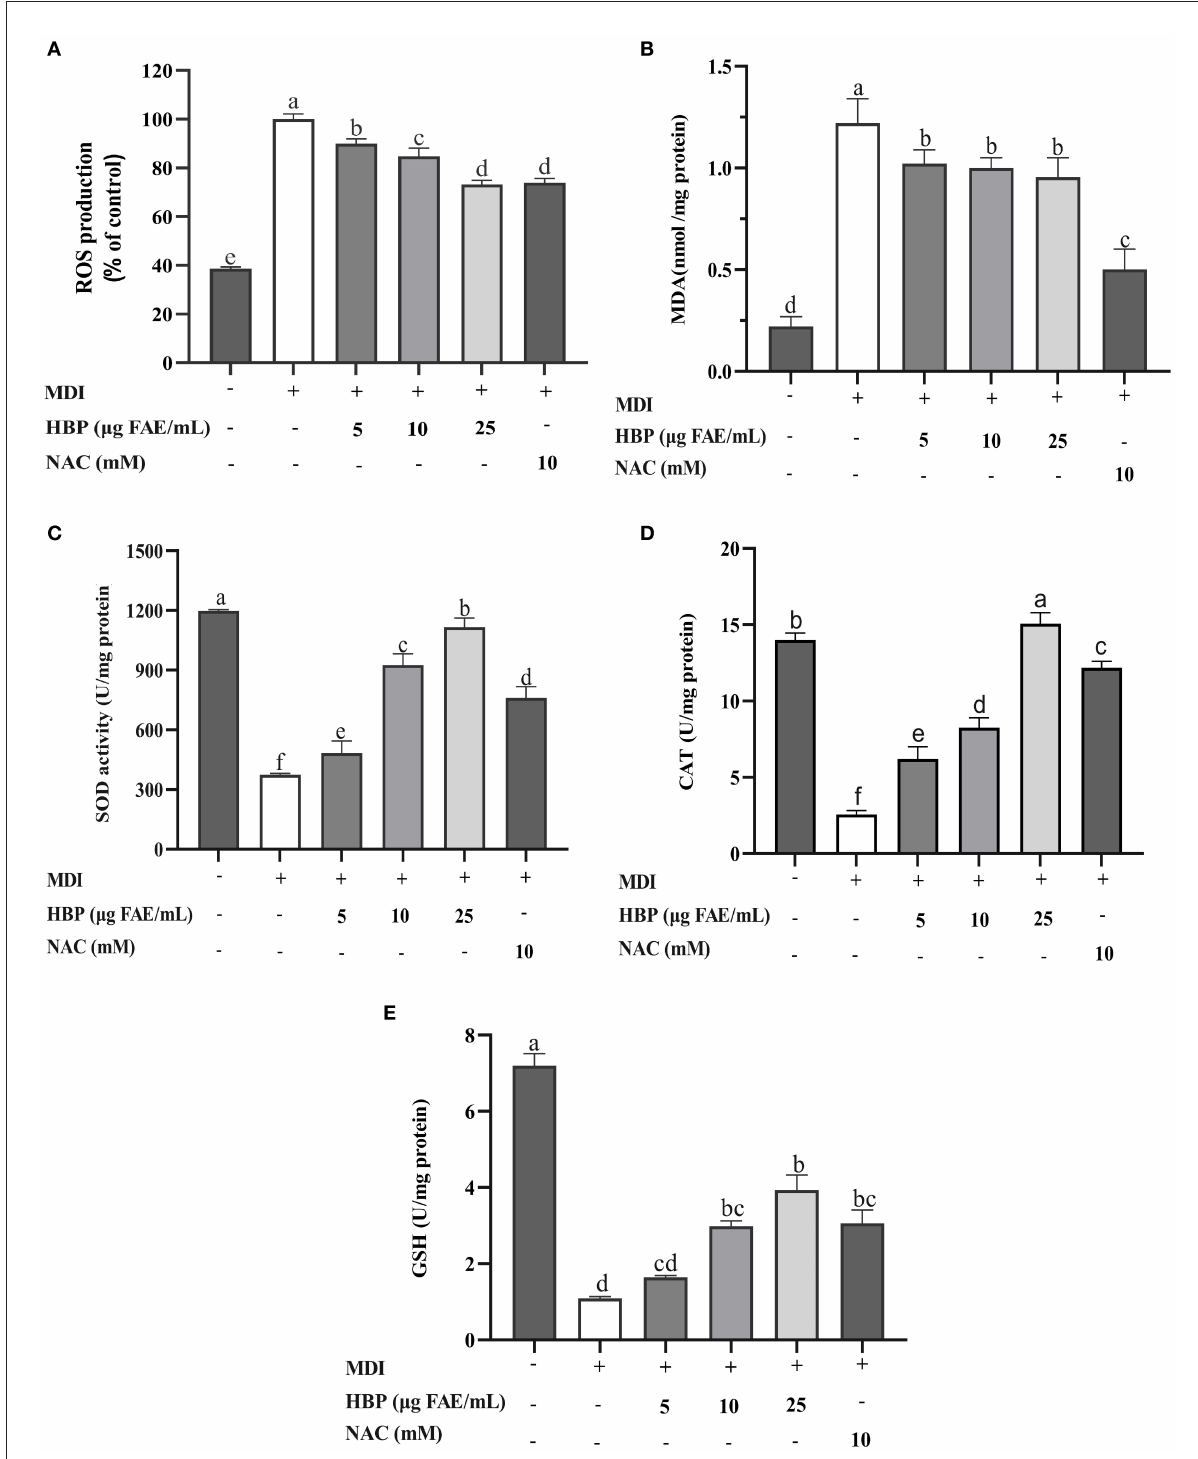
FIGURE5 Effect of HBP extract on antioxidant activity of 3T3-L1 adipocytes. (A) Reactive oxygen species (ROS). (B) Malondialdehyde (MDA). (C) Superoxide dismutase (SOD), (D) Catalase (CAT). (E) Glutathione (GSH), and Malondialdehyde (MDA). NAC was the positive control group, and different lowercase letters indicate significant differences ( p <